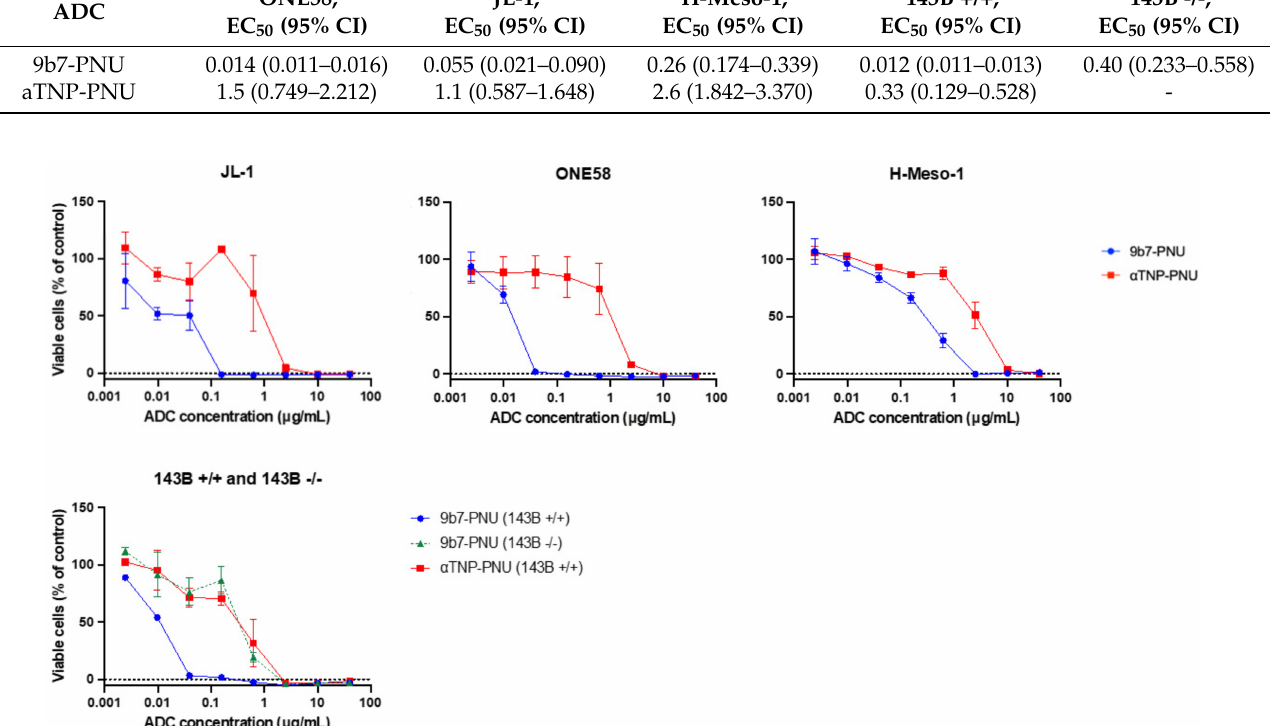
Figure 6. Effect of uPARAP-directed ADCs on human cancer cell lines. Graphs depict the viability of uPARAP-expressing cells after 6 days of culture in the presence of the indicated concentrations of 9b7-PNU (blue) or aTNP-PNU (red). The green dotted line shows the viability of uPARAP negative (143B -/-) cells, treated with 9b7-PNU in the same manner (receptor negative control). The percentage of viable cells is shown relative to an untreated control population. Data are presented as mean ±